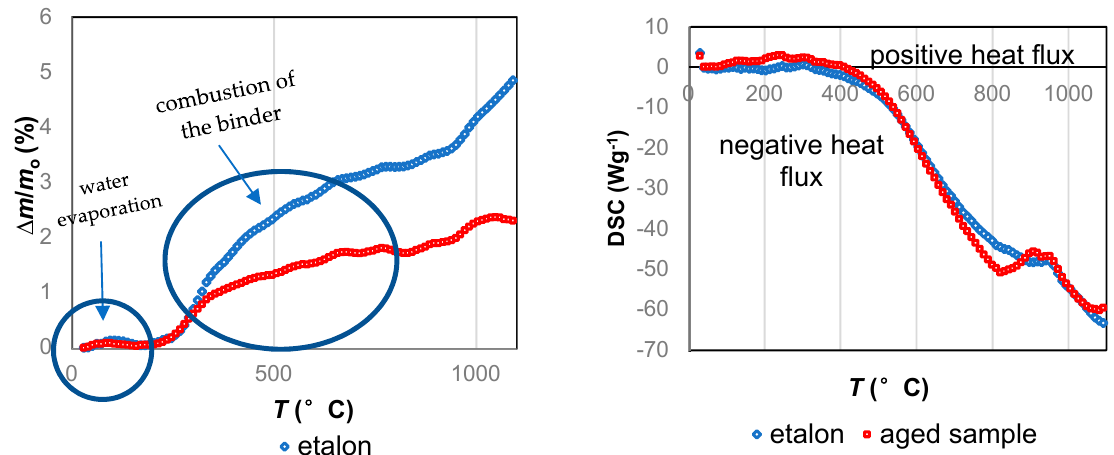
Figure 10. Results of the TGA-DSC analysis between new and aged samples. Normalized mass change ∆ m / m o , where ∆ m and m o are the mass change and the initial mass of the sample, respectively.